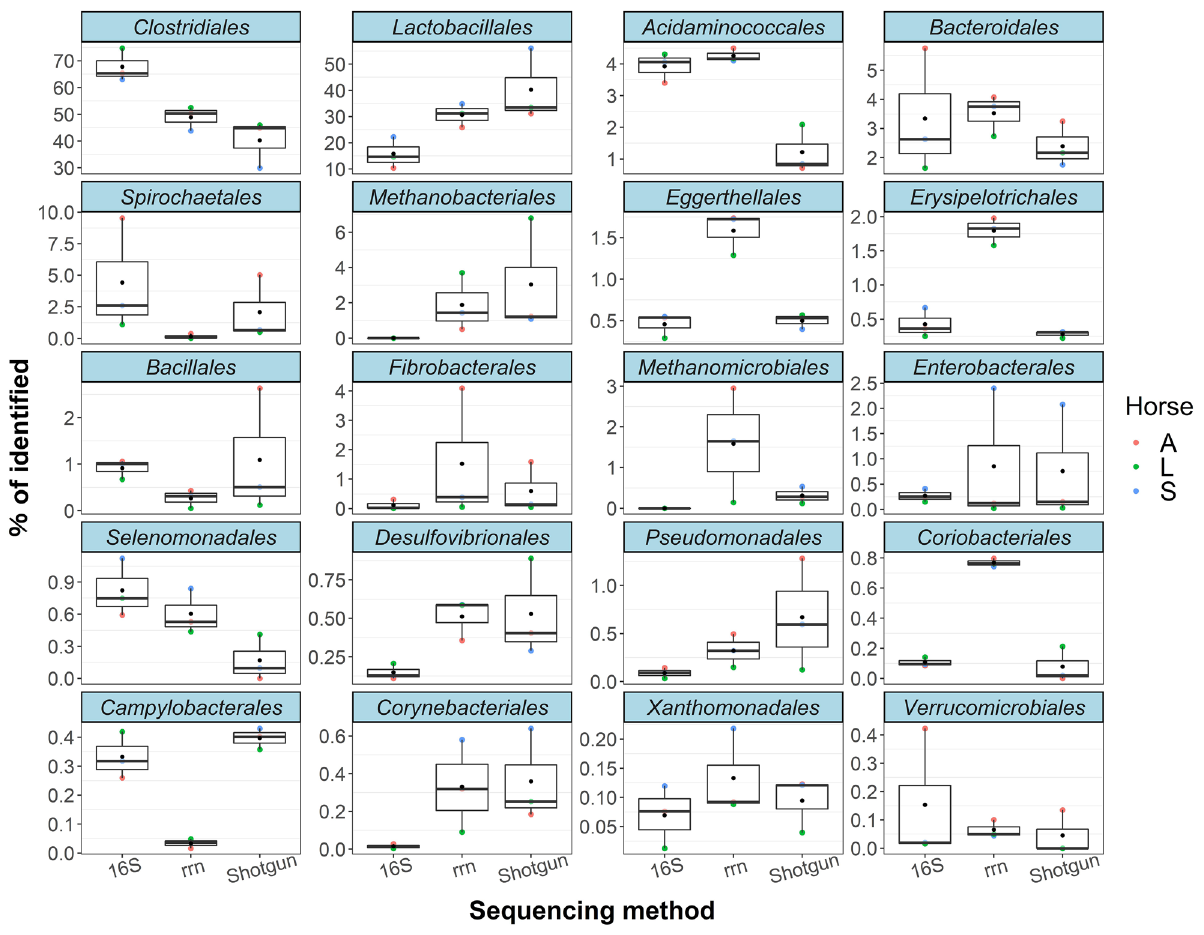
Figure 6. Boxplots of the top 20 orders with the highest average percentages. Sequencing methods are shown as in Fig. 2. Average values of the three horses were shown as black